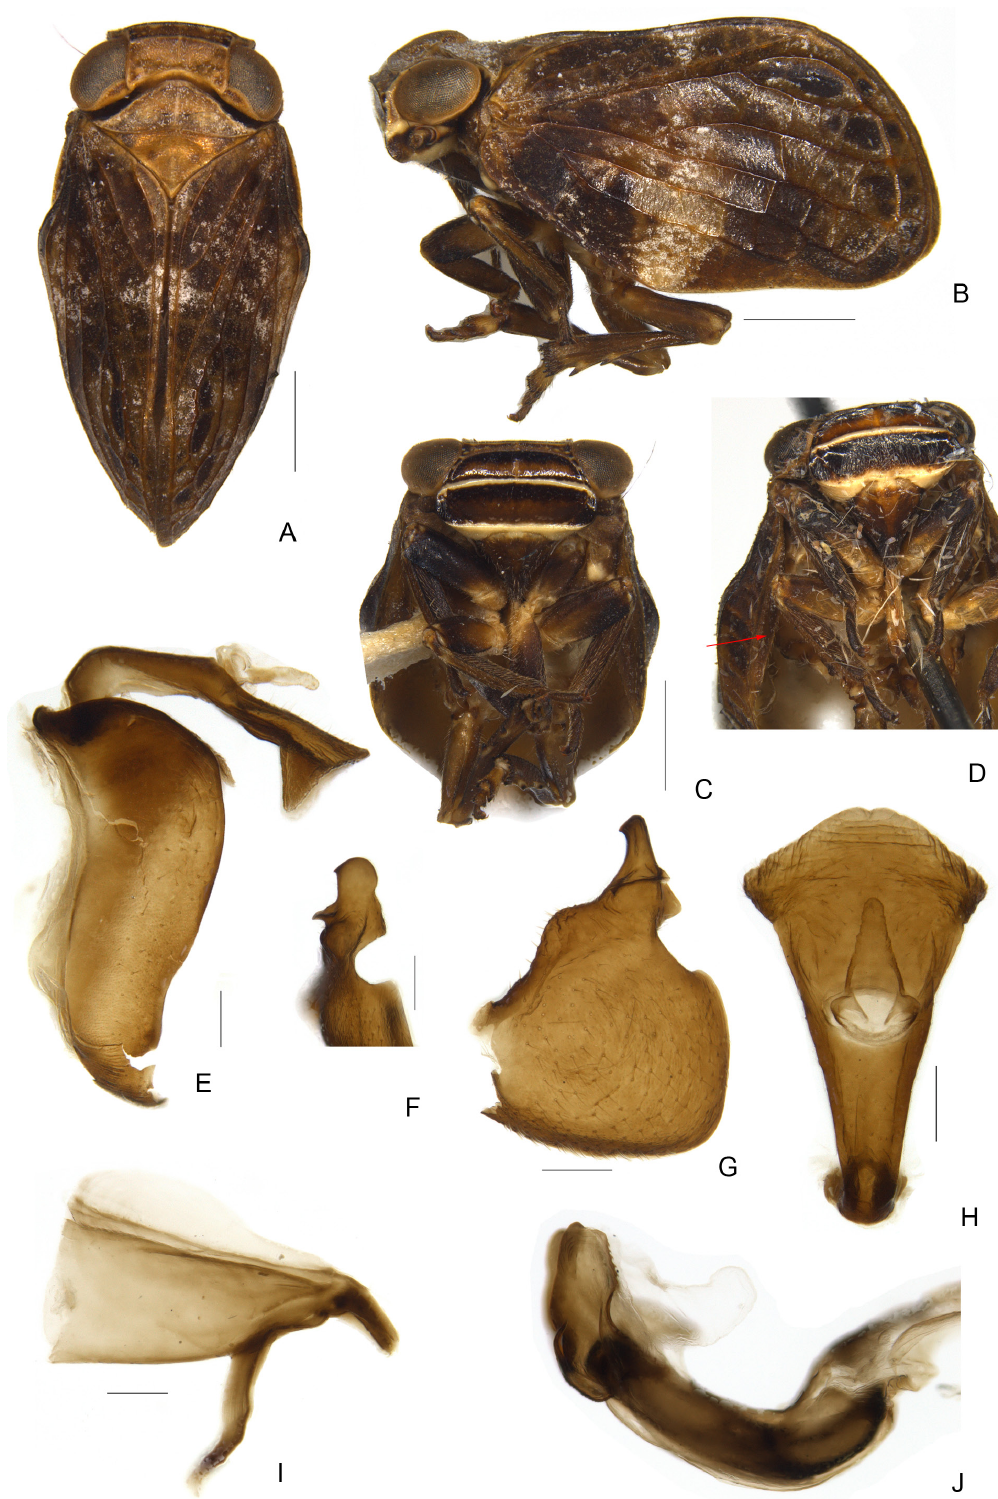
Fig. 6. Neokodaiana minensis Meng & Qin, sp. nov., holotype. A . Habitus, dorsal view. B . Habitus, lateral view. C . Frons and clypeus. D . Head and thorax, latero-ventral view. E . Male anal tube and pygofer, lateral view. F . Capitulum of style, dorsal view. G . gonapophyses IX and gonaspiculum bridge, right view. H . Male anal tube, dorsal view. I . Connective. J . Penis, lateral view. Scale bars = 1